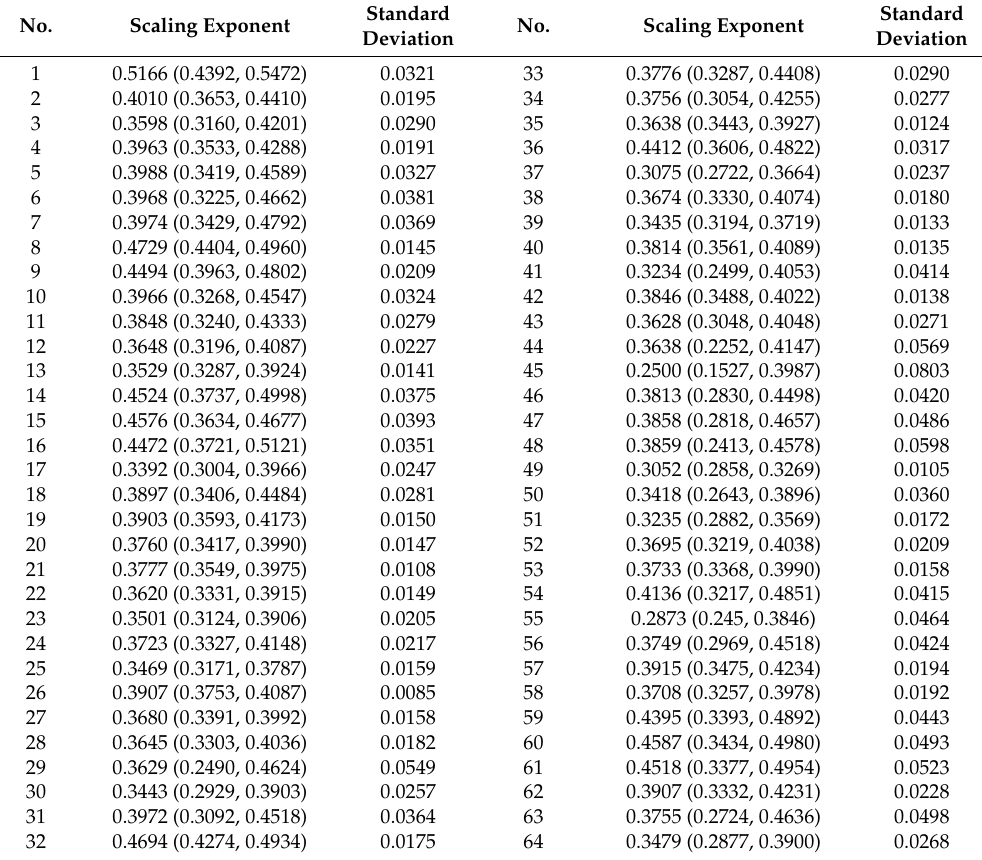
Table 2. Scaling exponent estimate of the AM series and their standard errors for all employed